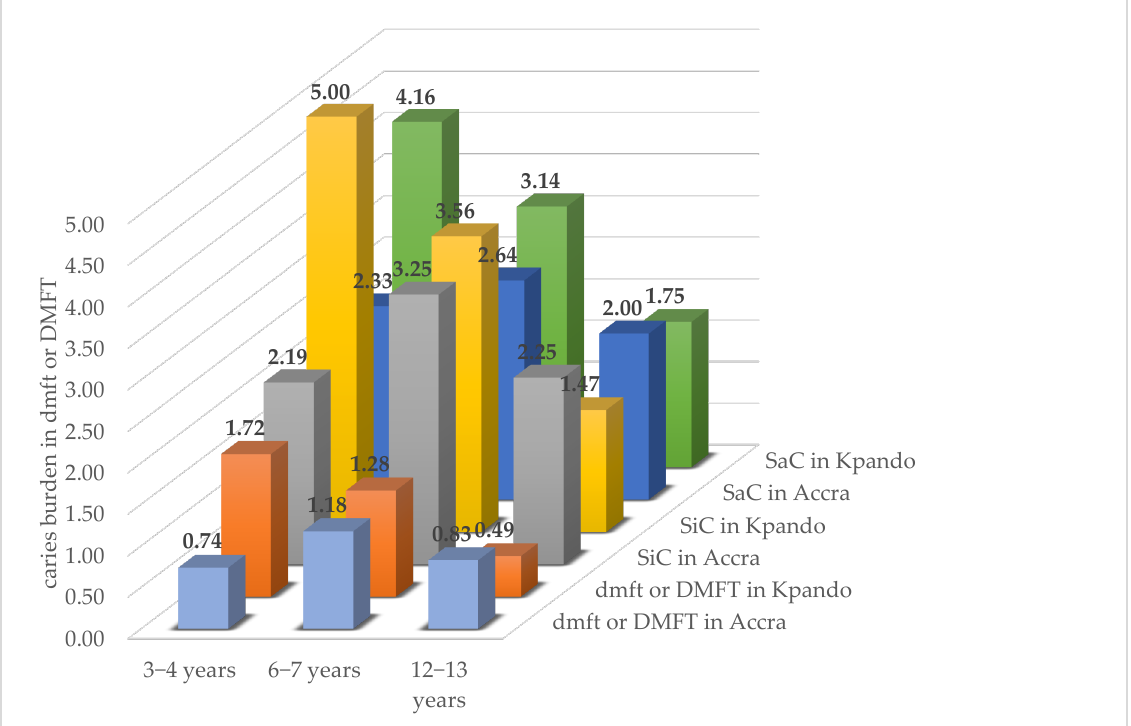
Figure 1. Regional comparison of caries experience (mean dmft in 3–4- and 6–7-year-olds or DMFT in 12–13-year-olds, accordingly, for SiC and SaC) in all three age groups. Socio-demographic aspects were used to stratify the population group by family status, parent’s level of education and occupation as well as by the school facility type. Outcomes